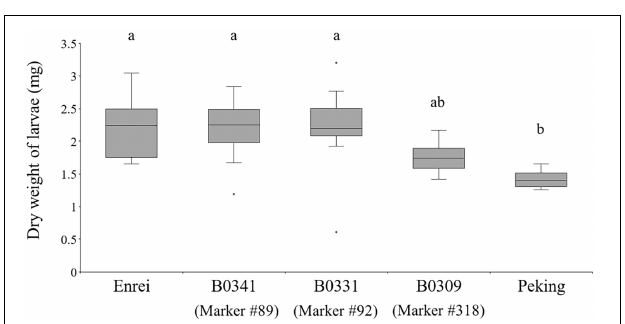
FIGURE 6 | The dry weight of common cutworm larvae fed on leaves of the three chromosome segment substitution lines (B0341, B0331, and B0309), Enrei and Peking. Different letters indicate significant differences between lines (Tukey’s test, n = 8, P <